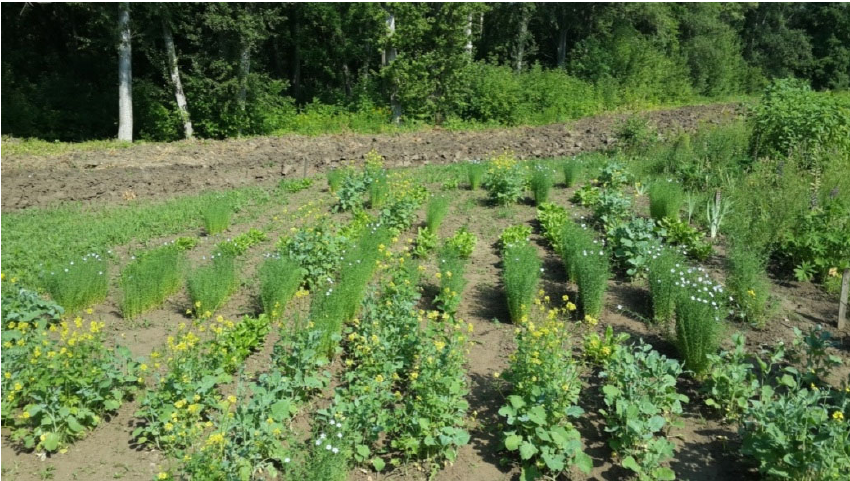
Figure 1. Experimental plot.